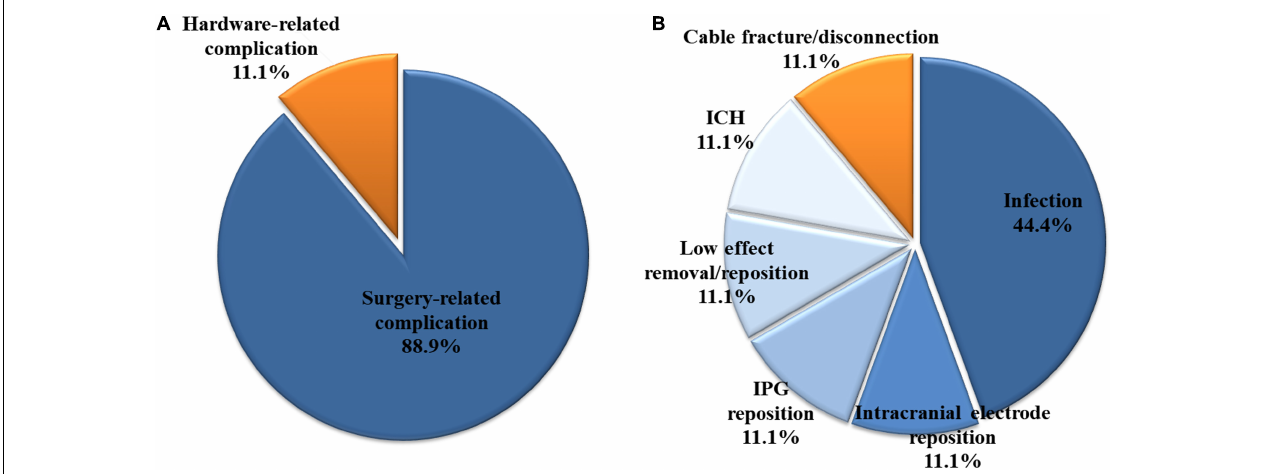
FIGURE 1 | Among the 426 patients who underwent bilateral deep brain stimulation, 27 had complications requiring revision surgery. (A) Three (11.1%) and 24 (88.9%) of the 27 patients had hardware- and surgery-related complications, respectively. (B) All three hardware-related complications were impedance problems due to extension fracture or disconnection. Among the surgery-related complications, infection was the most common, accounting for 44.4% (12/27 patients) of all complications. ICH, intracerebral hemorrhage; IPG, internal pulse generator.